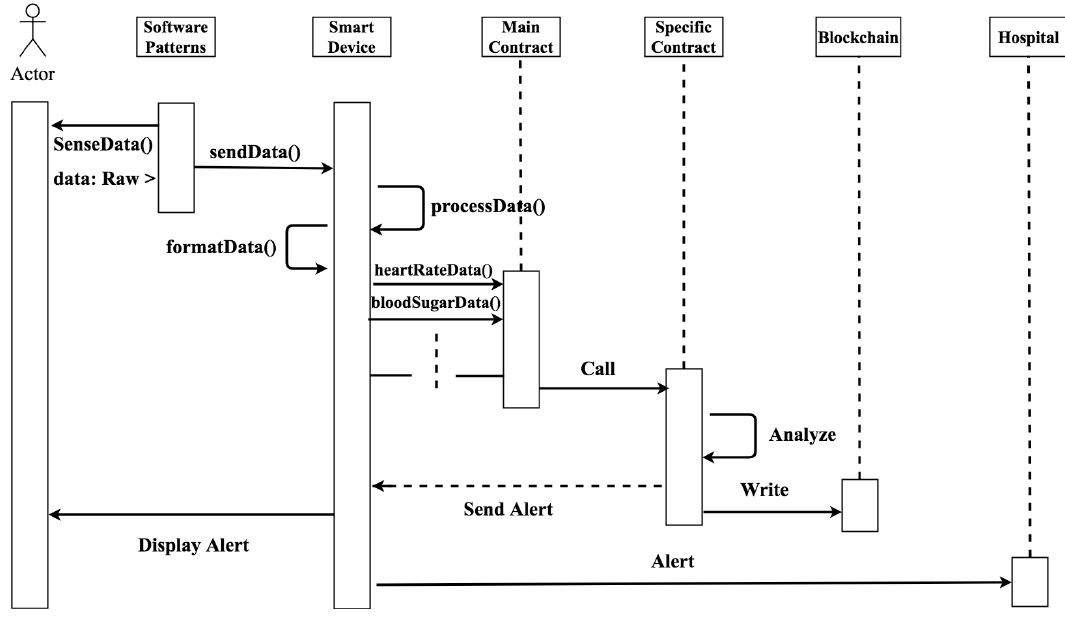
Figure 7. The logical execution flow of wearable device virtualization